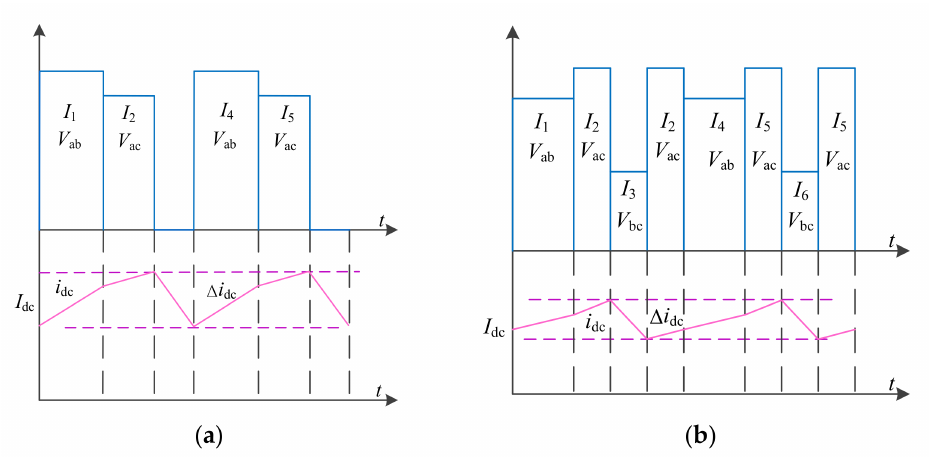
Figure 5. Waveforms of the inductor current ripple. ( a ) Traditional scheme ( b ) Proposed